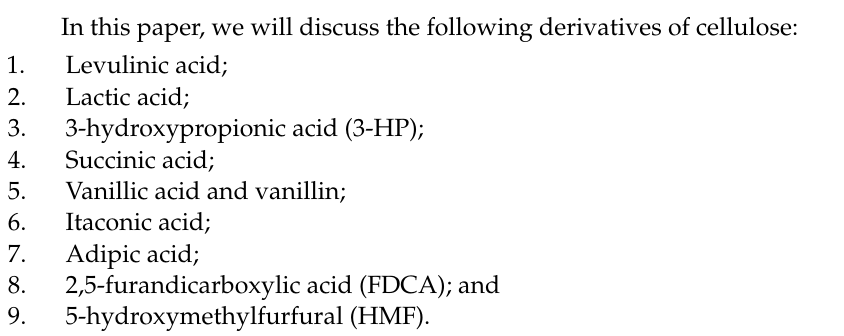
Figure 1. Biological and chemical routes for the production of top value-added chemicals derived from lignocellulosic biomass. Reprinted/adapted with permission from Ref. [7]. 2022 and Tanmay Chaturvedi or 2015 and Choi, S., Song, C.W. et. al. [7].